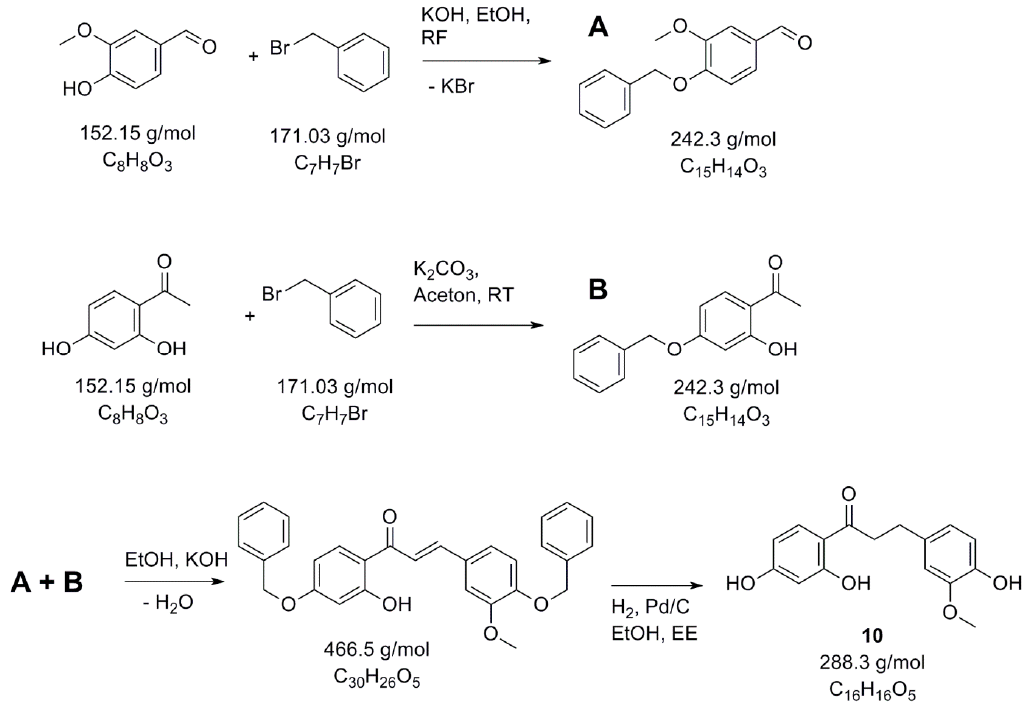
Figure A2. Synthesis of compounds A , B , and 10 .